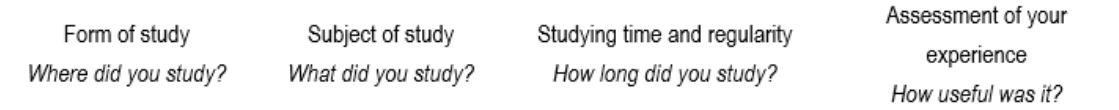
Questionnaire form on individual experience of